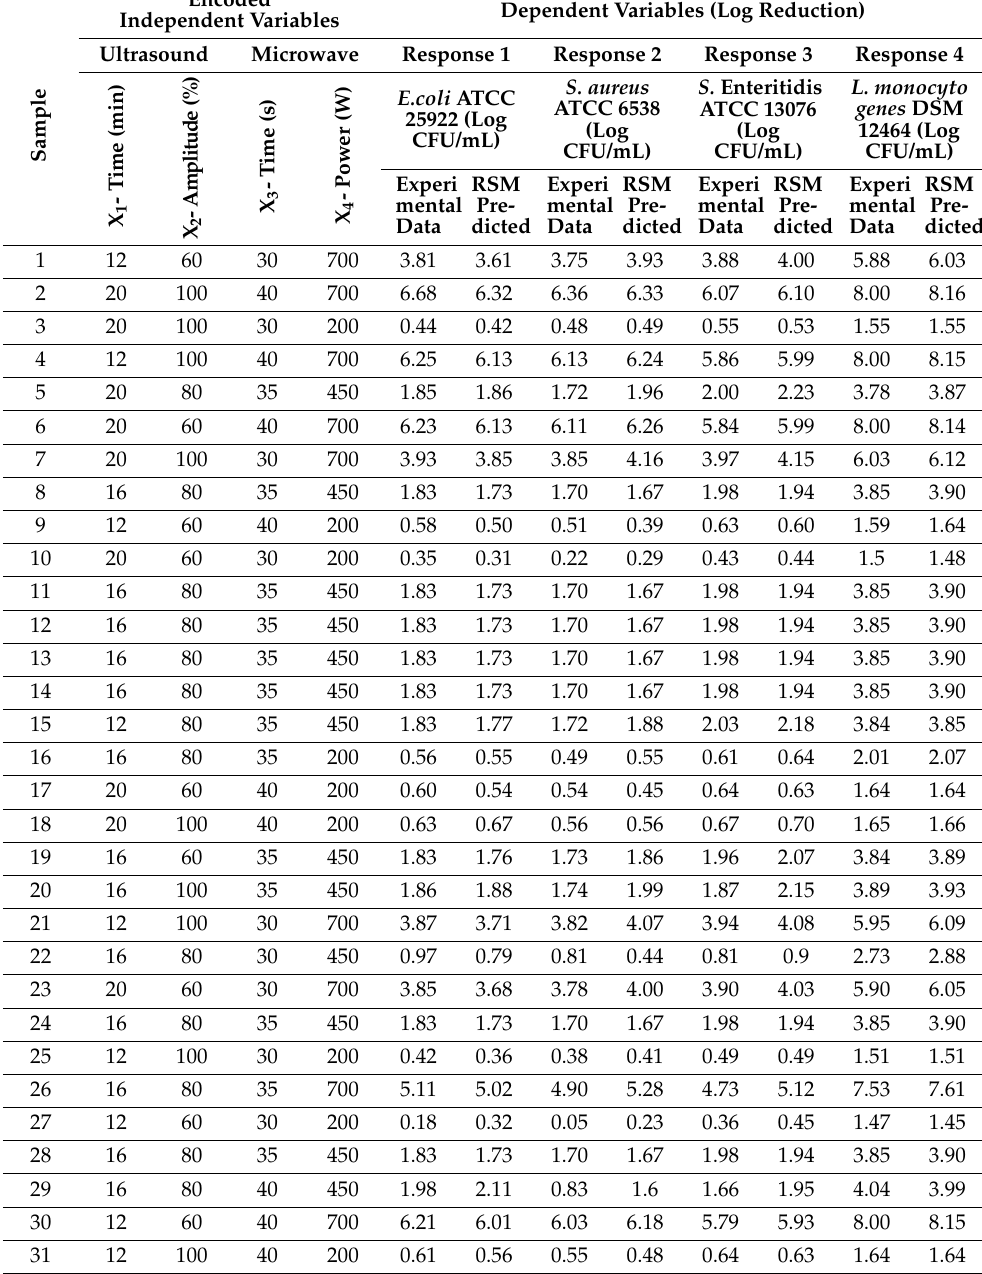
Table 2. Experimental studies on the inhibition of pathogens proposed by Box–Behnken Design (BBD) and experimental design matrix and response based on predicted